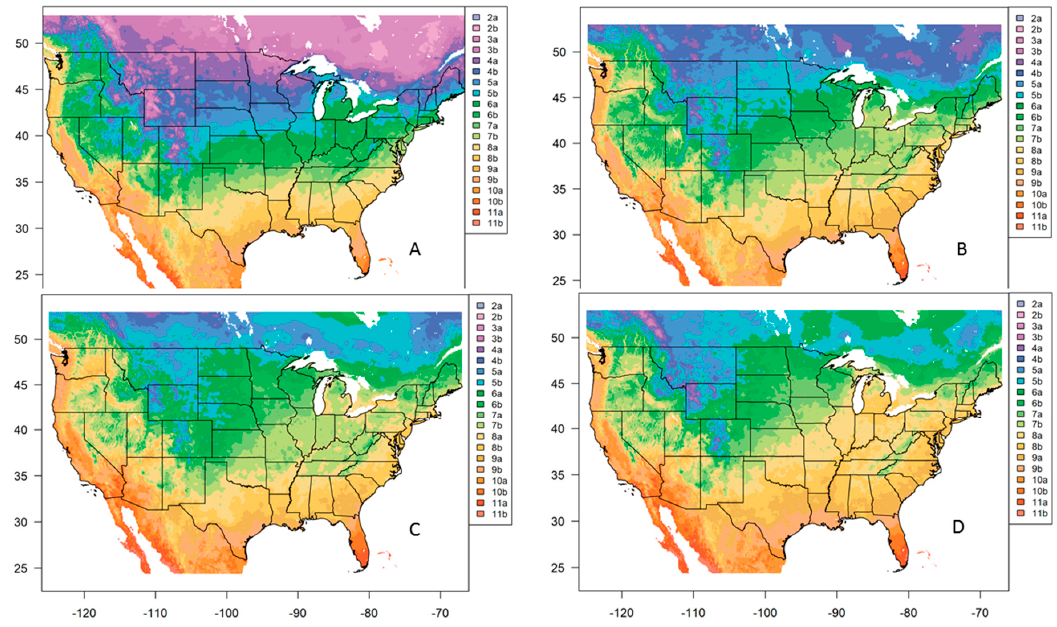
Figure 1. Current plant hardiness zones (panel A ) and plant hardiness zones under GFDL-ESM2G RCP8.5 (panel B ), CanESM2 RCP8.5 (panel C ), and HadGEM2-ES RCP8.5 (panel D ).